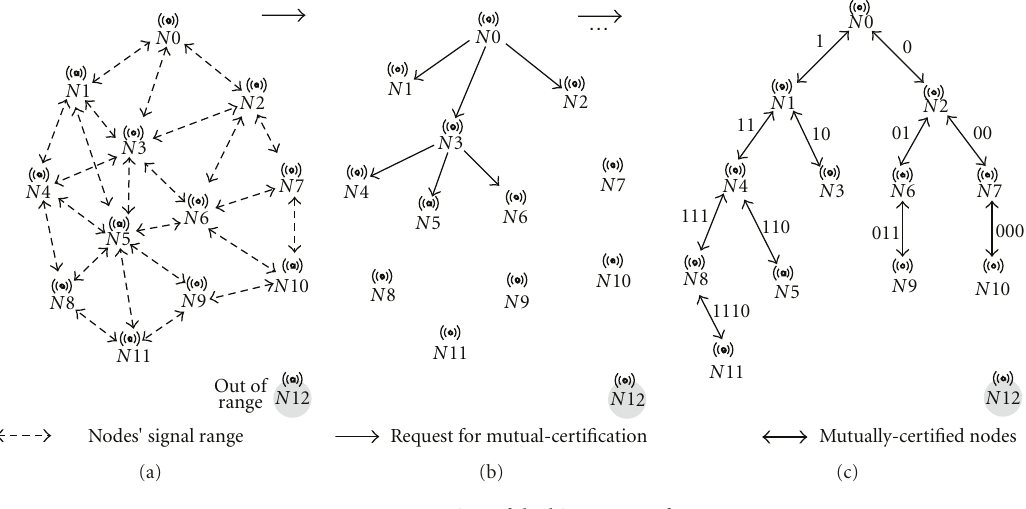
Figure 1: Formation of the binary tree of